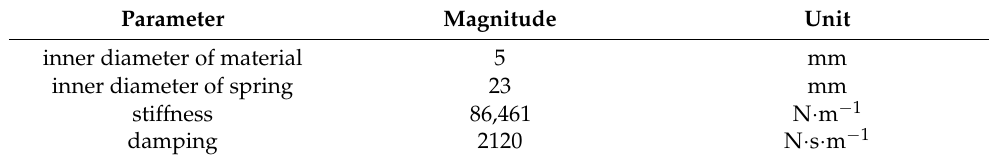
Table 1. Spring specific parameters.